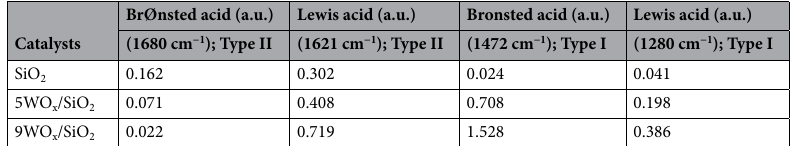
Table 1. Quantitave and qualitative of BrØnsted and Lewis acid site results by in situ DRIFTS of ammonia chemisorption a . a Ammonia adsorption on the DRIFTS cell at 50 °C, 0.1 Mpa (after pretreated in N 2 ; 1 h 550 °C).